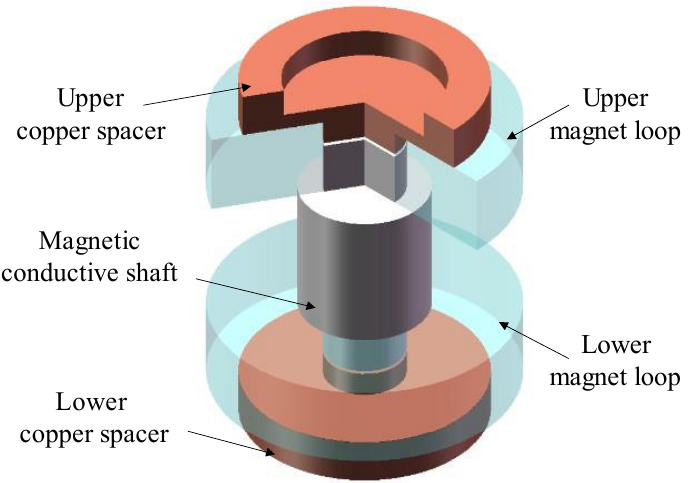
Figure 9. Concentric nested configuration of copper spacers, magnet loops, and magnetic conductive shaft. The model was partially sectioned.